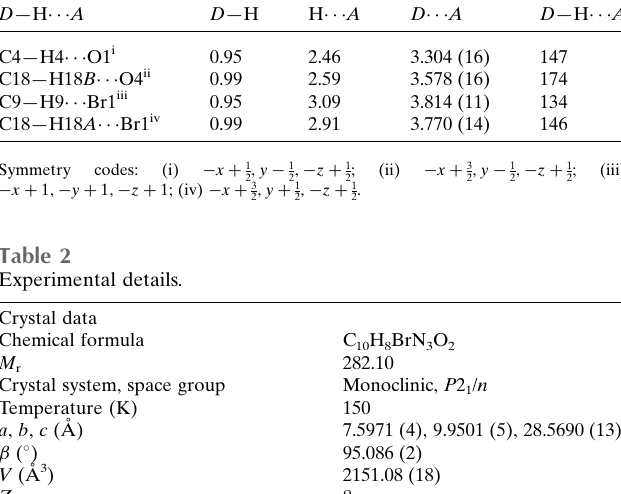
Table 1 Hydrogen-bond geometry (A˚ , (cid:3) ).